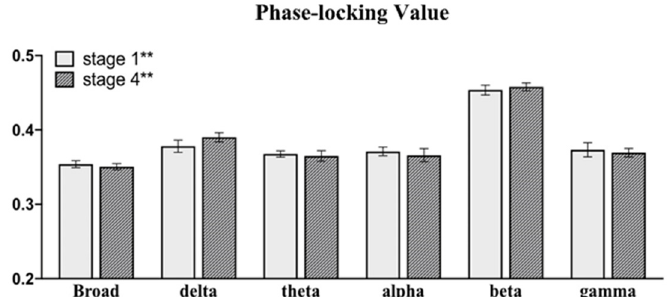
Figure 11. The mean adjacency matrices of three different stages of the broad, delta, and theta frequency bands in the two groups. In addition, there are different connections between the two stages in each group, Stage 2/2* and Stage 4/4*. The first is that the connections of Stage 2/2* before sonication are greater than those of Stage 4/4*, and the latter is that the connections of Stage 4/4* after sonication are greater than those of Stage 2/2*.